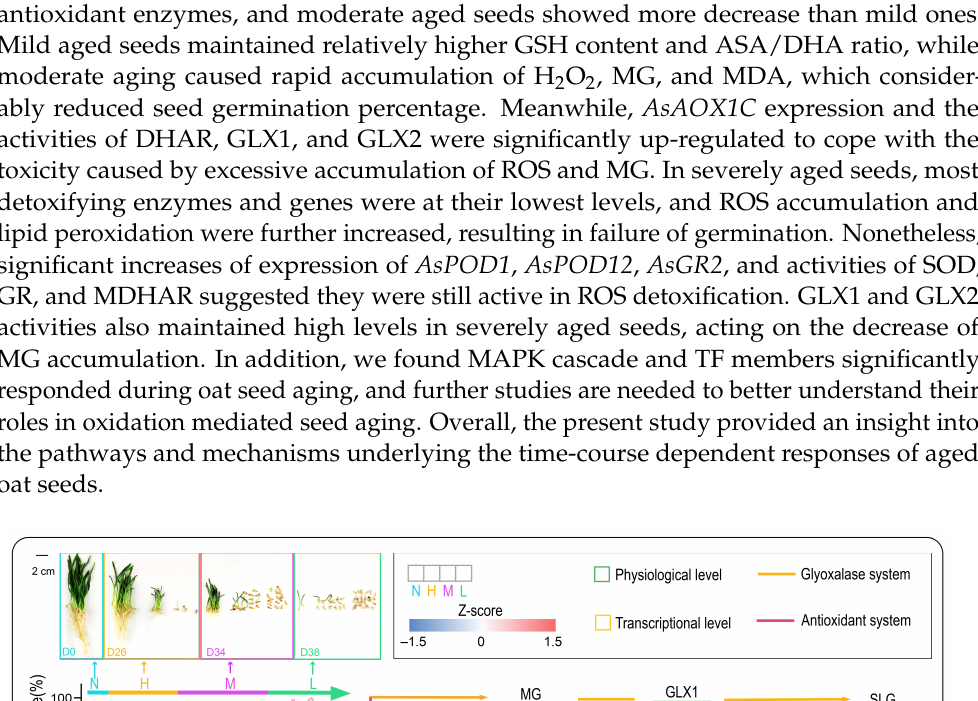
top 20 TFs; Table S1: Details of genes and their primers for qRT-PCR